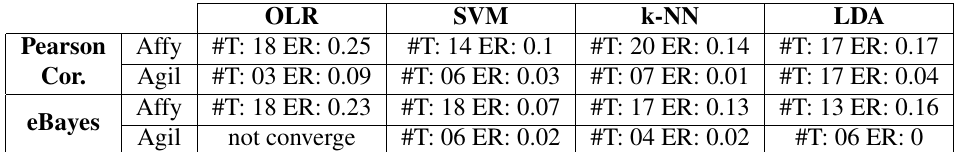
Table 6: Results for classifiers (columns), filtering methods (rows) at the transcript level. #T - number of transcripts; ER - Error Rate